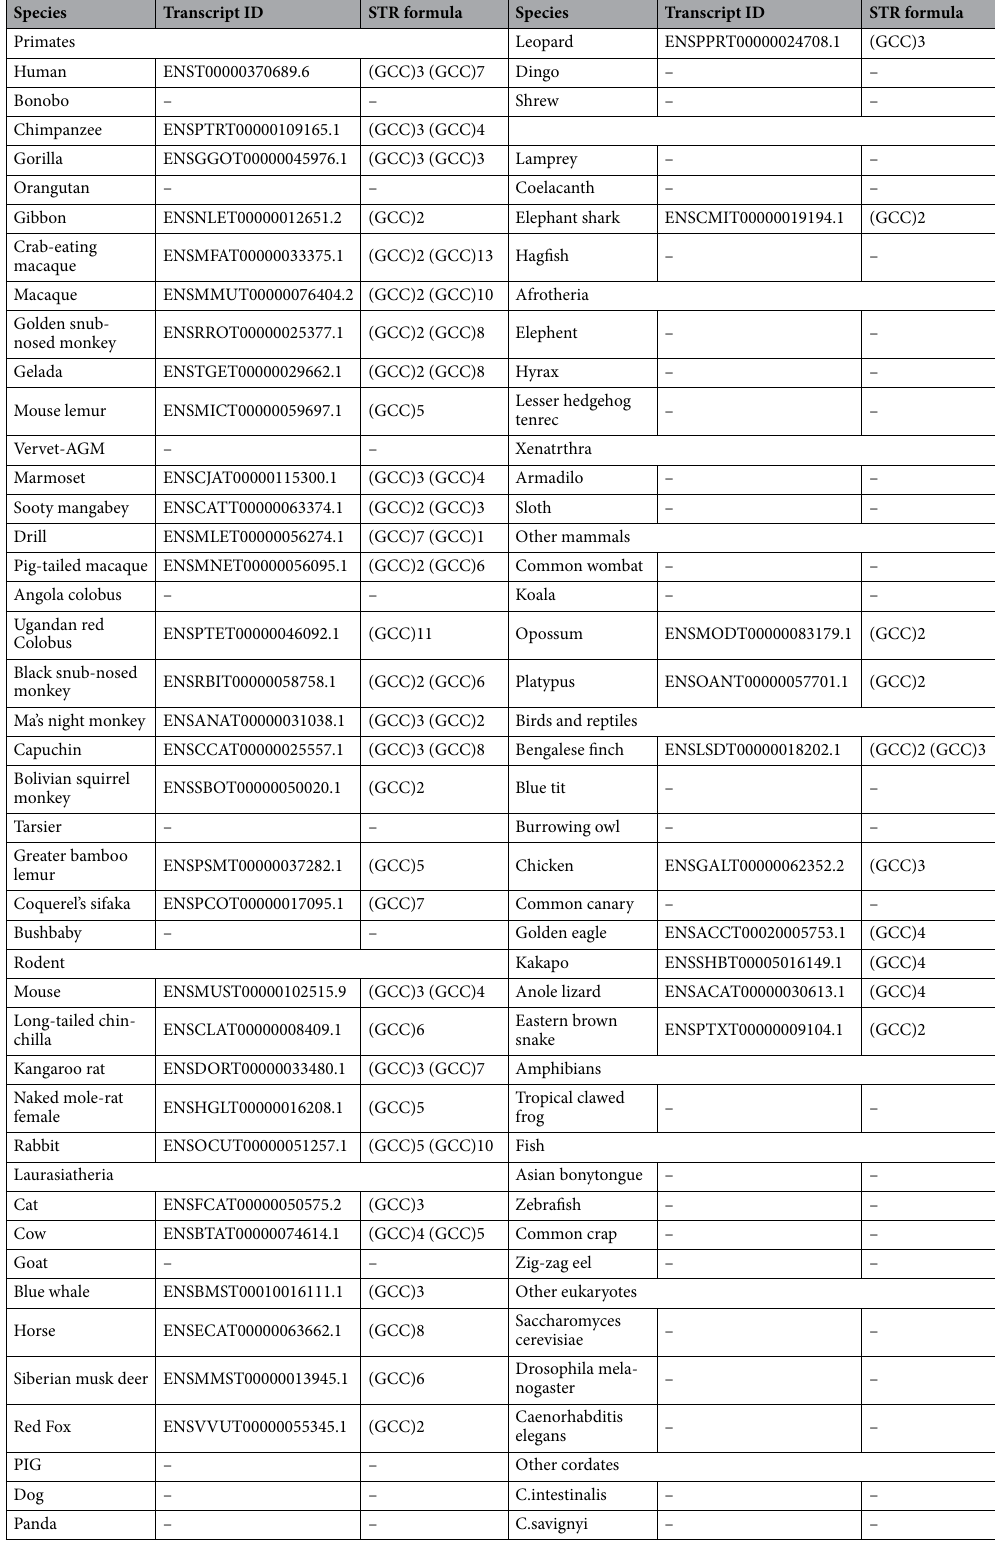
Table 1. Status of the PRKACB (GCC)-repeat across